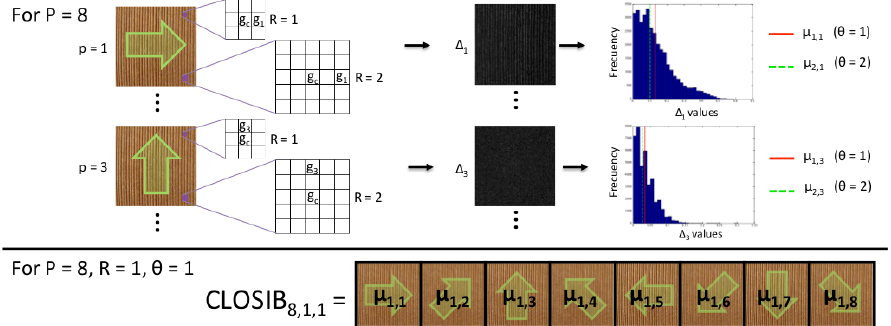
Figure 1. Overview of Complete Local Oriented Statistical Information Booster (CLOSIB) method. Example about the calculation of CLOSIB 8,1,1 on an